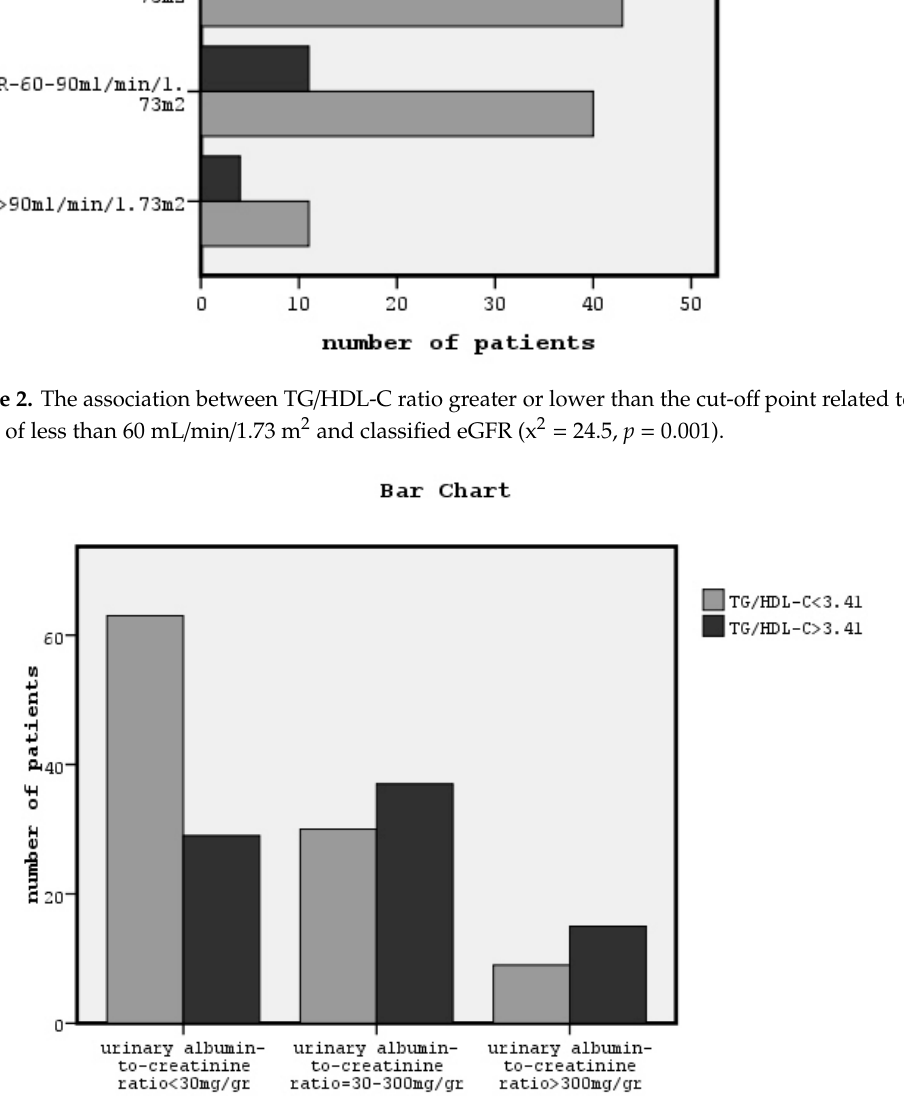
Figure 3. The association between TG/HDL-C ratio greater or lower than the cut-off point related to an eGFR of less than 60 mL/min/1.73 m 2 and classified urinary albumin excretion (x 2 = 12.5, p = 0.002).